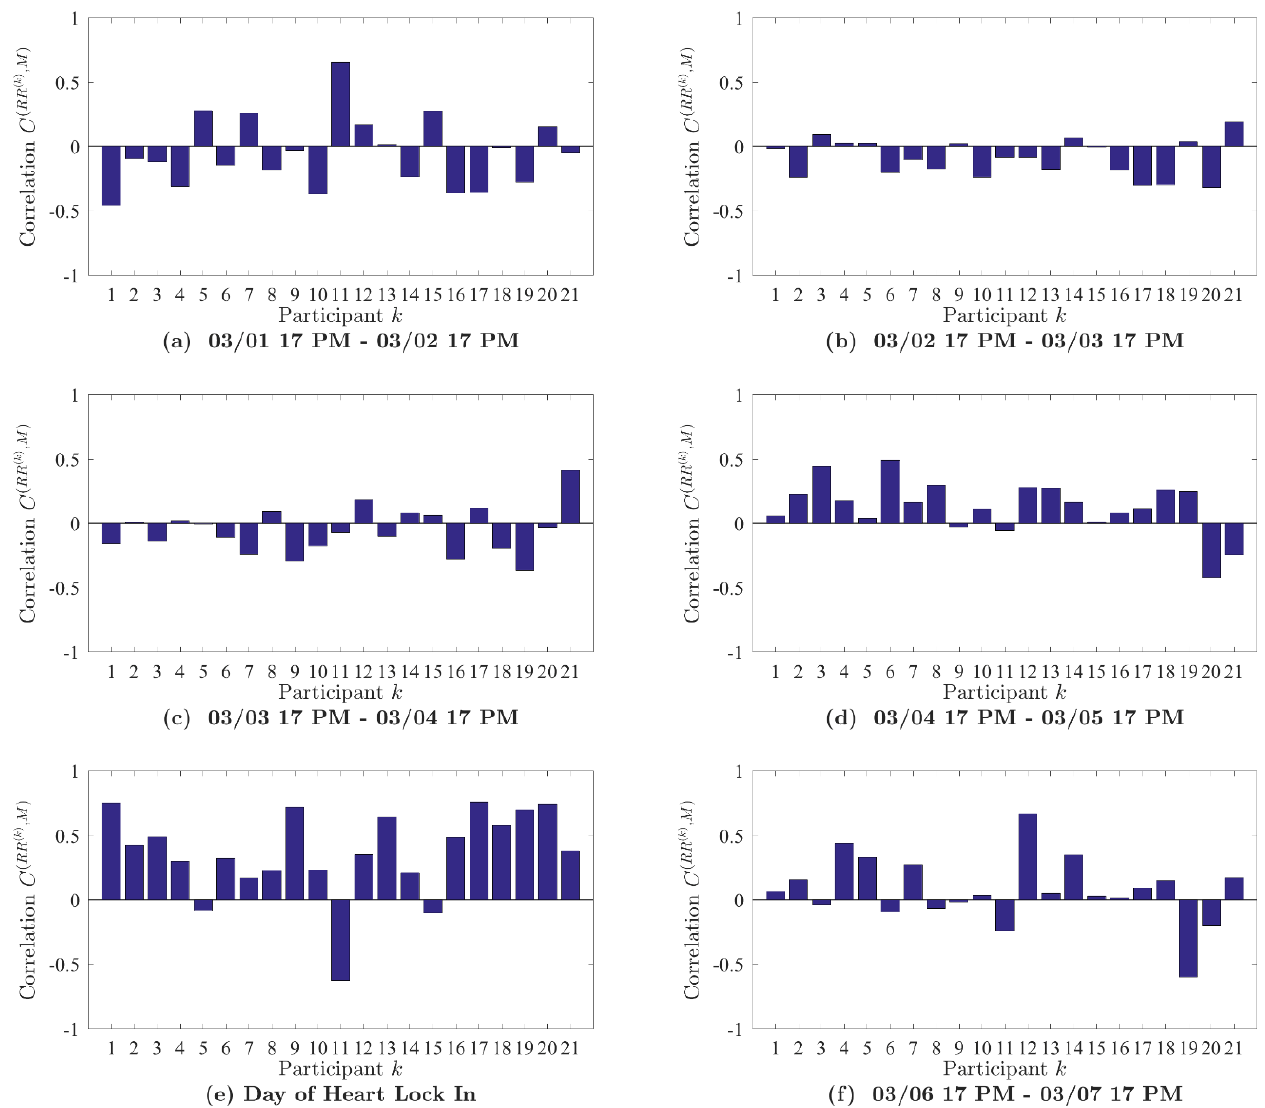
Figure A3. The results of the analysis of the LMF-HRV-synchronization for New Zealand. Each part of the figure displays participants’ LMF-HRV-synchronization for the indicated day. Plot (e) corresponds to the day of the Heart Lock-In. Note that for almost all of the participants’ the highest positive LMF-HRV-synchronization values were obtained during the day of the Heart